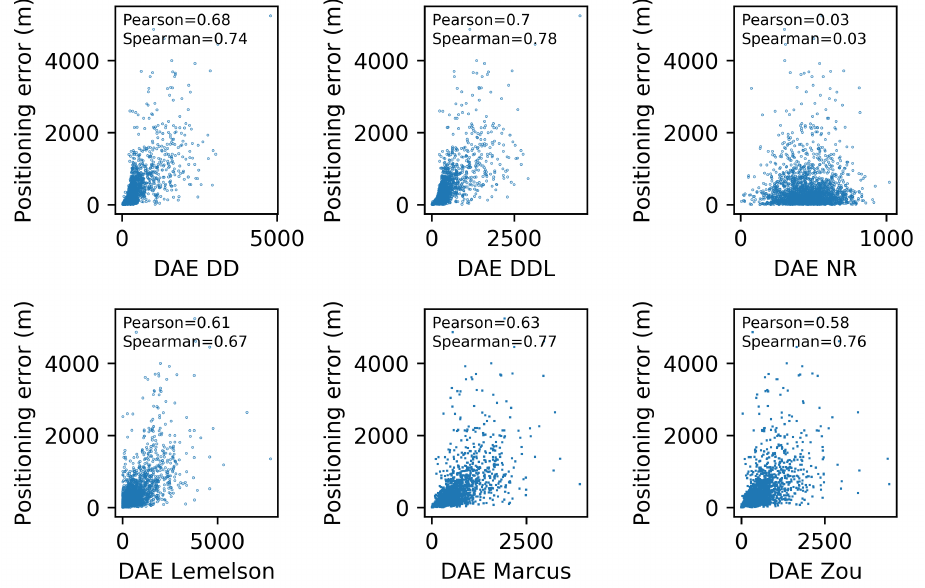
Figure 6. Scatter plots for five DAE methods and one baseline, depicting the DAE estimates against the actual positioning error values. Pearson’s correlation coefficient as well as Spearman’s rank correlation coefficient are indicated for each method. The validation set of the Sigfox dataset is